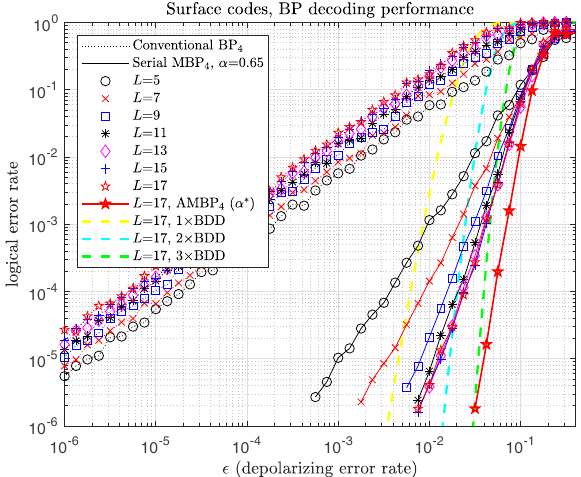
Fig. 5 Performance curves of several surface codes using the conventional BP 4 and serial (A)MBP 4 . The maximum number of iterations is T max ¼ 150 . The technique of fi xed initialization is used with ϵ 0 =